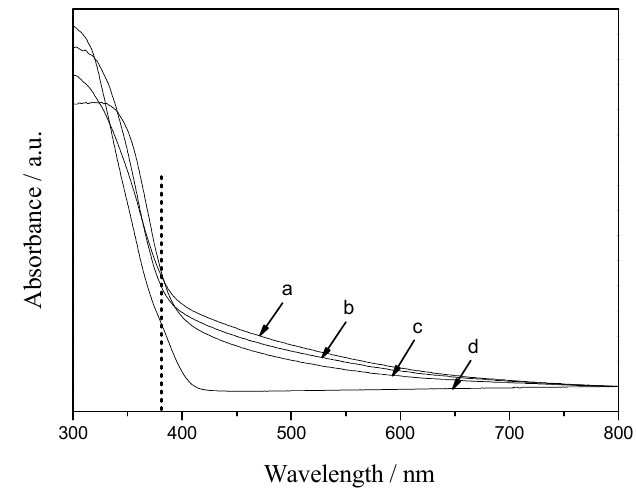
Figure 6. UV–vis diffuse reflectance spectra of (a) R-TiO 2 /SiO 2 ; (b) WH-TiO 2 /SiO 2 ; (c) D-TiO 2 /SiO 2 ; and (d) P25. Table 2. Band gap energy calculated by UV–vis diffuse reflectance spectra.